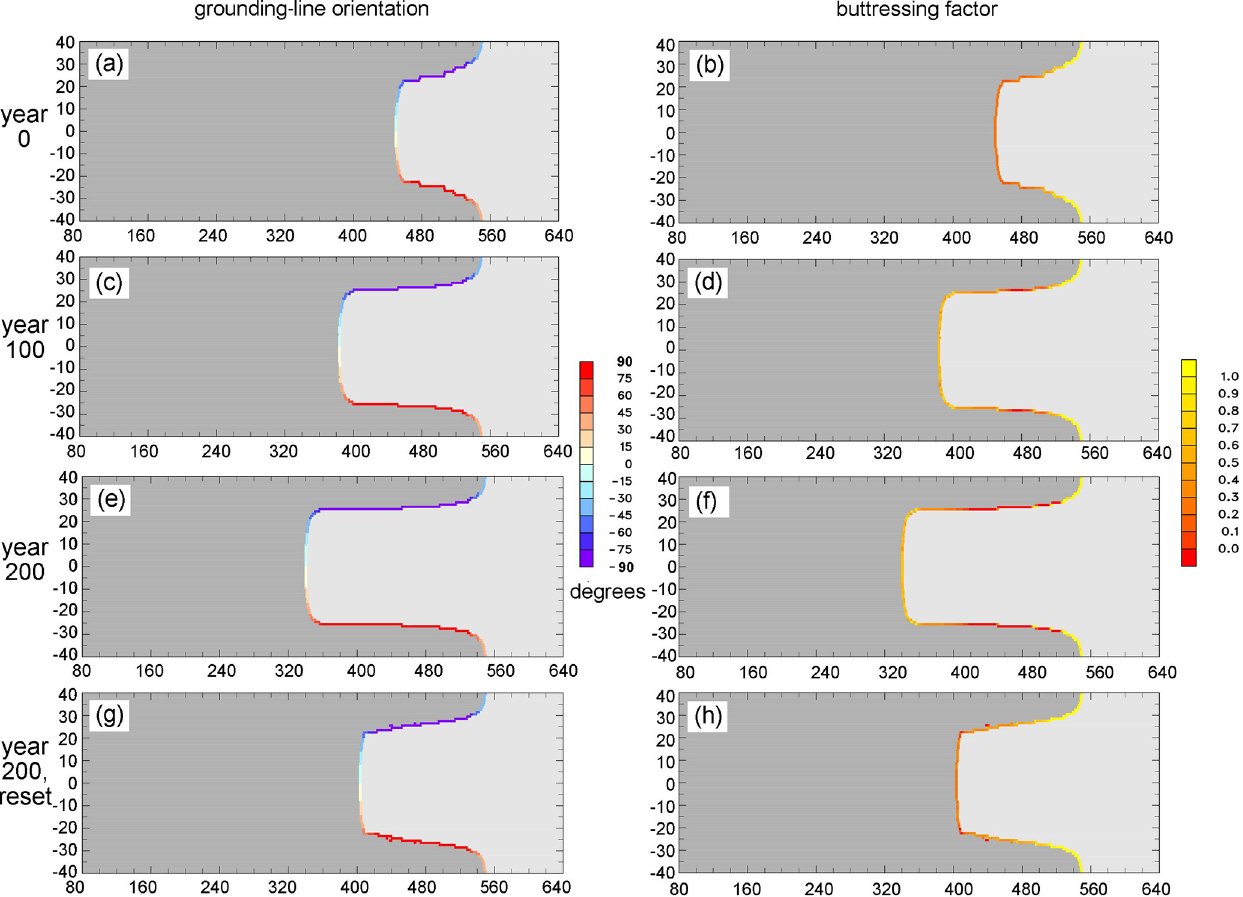
Figure 5. As Fig. 4 for quantities at grounding lines. (a, c, e, g) Orientation of grounding line (degrees counterclockwise of normal vector ( n x , n y ) from the along-fjord x axis, given by algorithm in Sect. 2). (b, d, f, h) Buttressing factor θ .